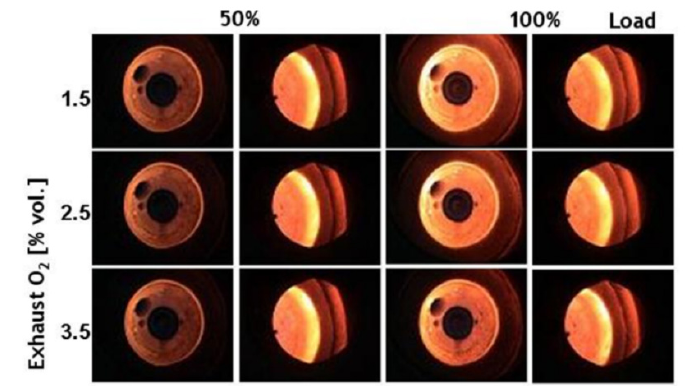
Figure 4. Flame images (front and side) for different combustion loads and exhaust O 2 concentrations for air combustion.